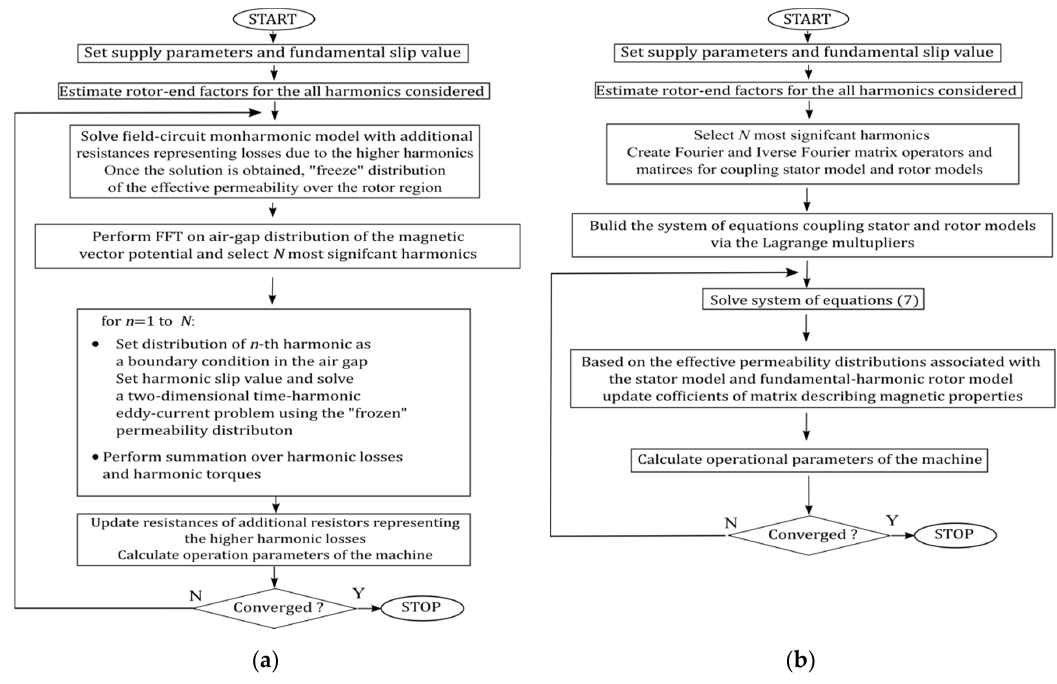
Figure 7. Comparison of the ideas of the different multi-harmonic model: ( a ) model with the weak coupling, ( b ) model with the strong coupling.